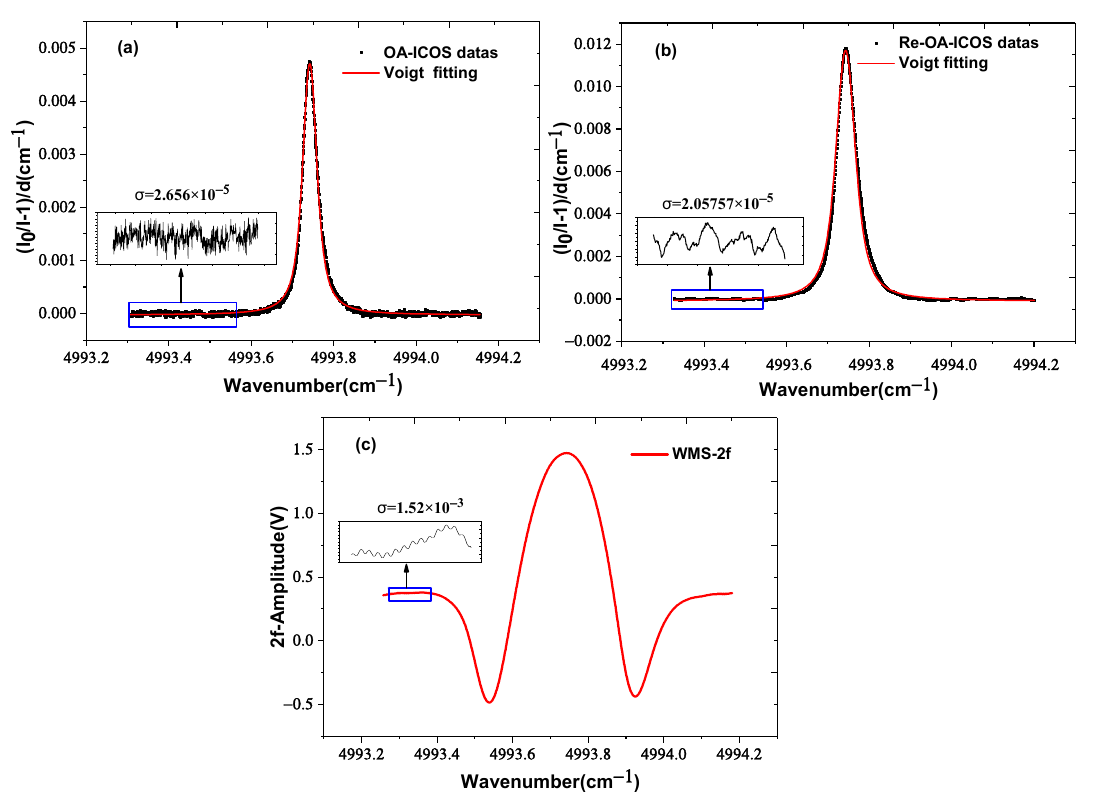
Figure 8. Comparison of different methods. ( a ) OA-ICOS: SNR is 179; ( b ) RE-OA-ICOS: SNR is 573; ( c ) WM-RE-OA-ICOS: SNR is 1288, which is 2.3 times that of the RE-OA-ICOS, and 7.2 times that of OA-ICOS. The 400 ppm CO 2 gas was introduced into the three measuring approaches, respectively, and the external environment and data collection methods were consistent.